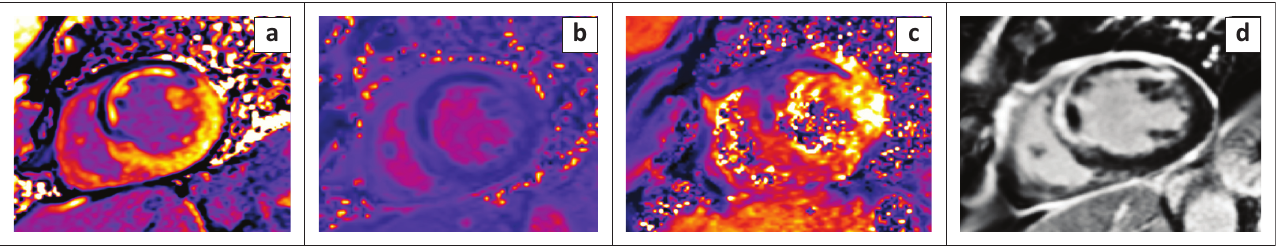
FIGURE 2: Mid short-axis cross-section through the left ventricle and right ventricle. T1, T2, T2 * maps and LGE images (from left to right respectively) show a large septal, anteroseptal and anterior wall infarct (LAD territory) acute MI. The T2 * maps show IMH and MVO which can be seen on the LGE image as a black penumbra around the ‘bright’ infarcted myocardium.